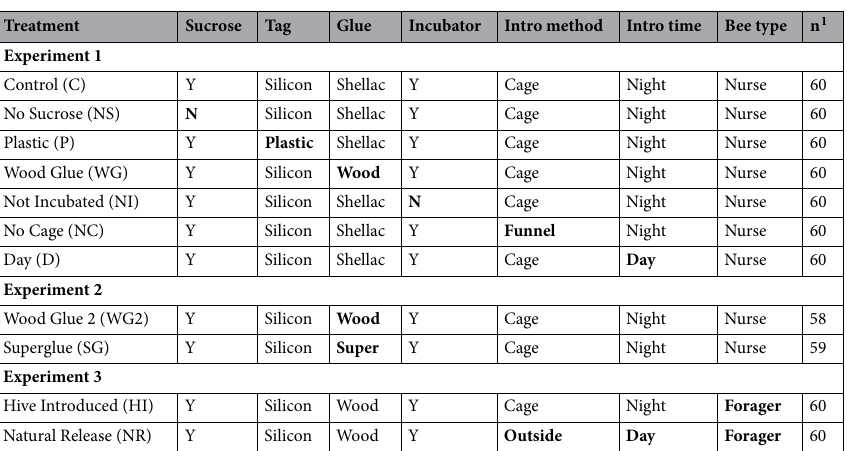
Table 1. Experimental design used for preparation and introduction of treatment groups. of bees per treatment (20 per colony, 60 total). Some died before introduction Parameters that differ from the control are in